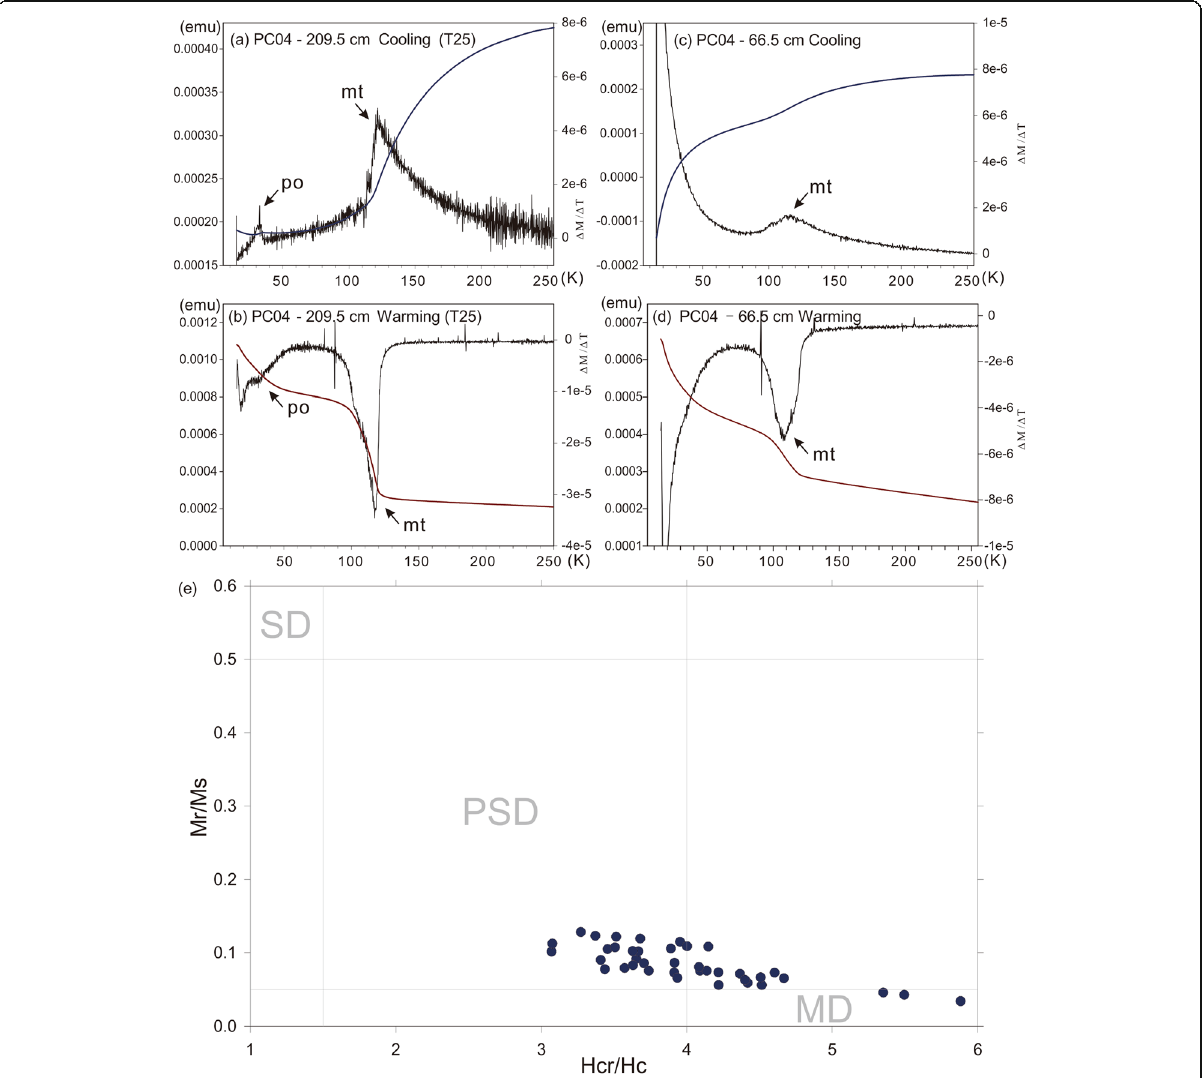
Fig. 5 SQUID-VSM magnetic susceptibility analyses of bulk marine sediments from a , b 209.5 and c , d 66.5 cm depth in PC04 during a , c cooling and b , d warming over temperatures from 5 K to room temperature. Both heating and cooling rates were 3 K/min. The magnetic susceptibility scale (emu) on the left of each plot is reported as Δ M/ Δ T on the right. Peaks at 119 K and 34 K indicate the presence of magnetite (mt) and pyrrhotite (po), respectively, in the bulk sediments. Pyrrhotite peaks are observed throughout PL04 and in three turbidite beds in PC04. e Day plot (Day et al. 1977) of hysteresis magnetization and coercivity parameter ratios. The clastic mud beds and silty-sand laminae samples plot in the pseudo-single domain (PSD) and multi-domain (MD) fields, indicating that most of the magnetic particles are uniformly